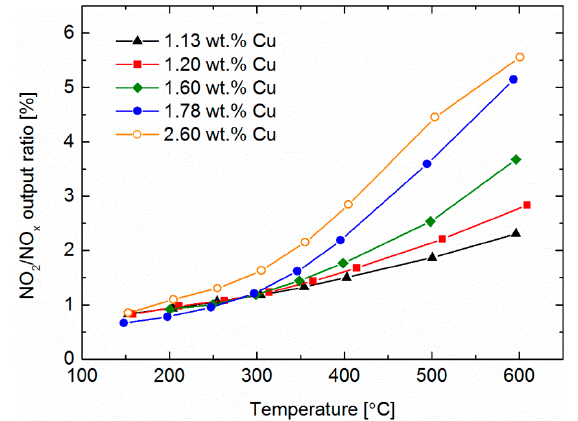
Figure 5. NO 2 formation during NO oxidation. Inlet: 400 ppm NO, 8% O 2 , 5% H 2 O.